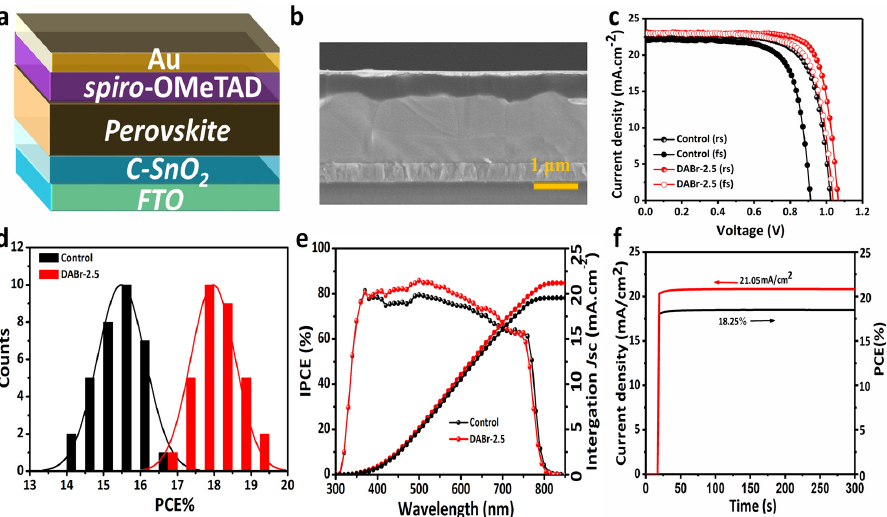
Figure 5. ( a ) Schematic diagram of the planar prepared device. ( b ) Cross − sectional SEM image of the final device based on DABr − 2.5. ( c ) Current density-voltage (J − V) curves scanned under forward and reverse bias for prepared devices based on the control and DABr − 2.5 − treated films. ( d ) The statistical distribution of PCEs recorded for 30 tested devices for each type. ( e ) Incident to photo-conversion efficiency (IPCE) spectra of devices with the control and DABr − 2.5 − treated films. ( f ) Stable current output and PCE curves of the DABr − 2.5 − based device at the maximum power